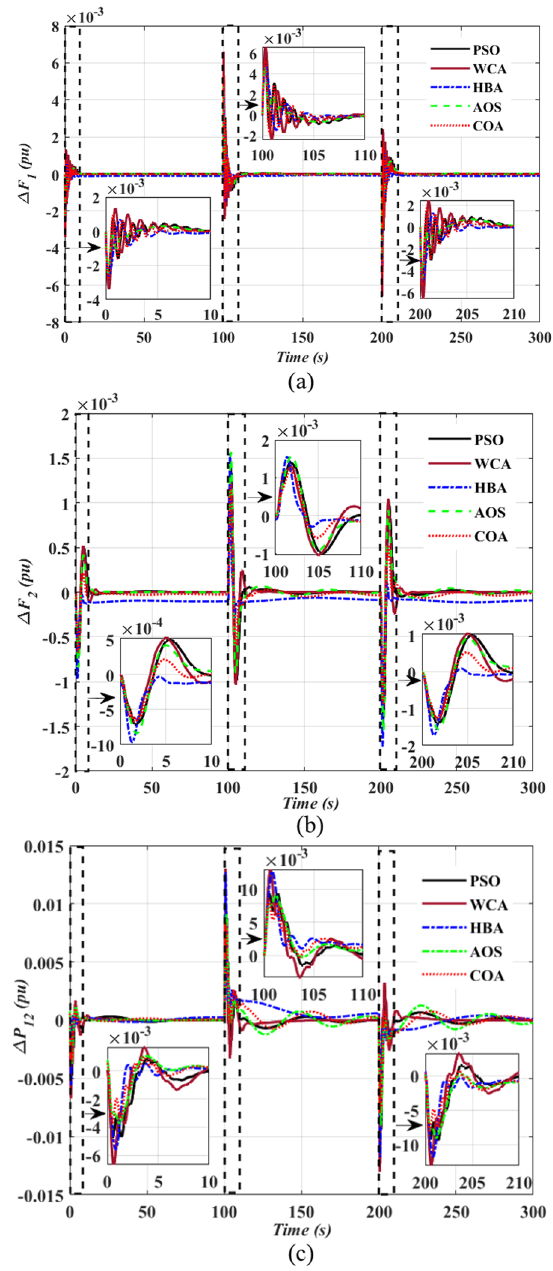
Fig. 12 System responses due to various step load changes in Area 1 while including FOPID controller a (cid:31) F 1 , b (cid:31) F 2 , c (cid:31) P